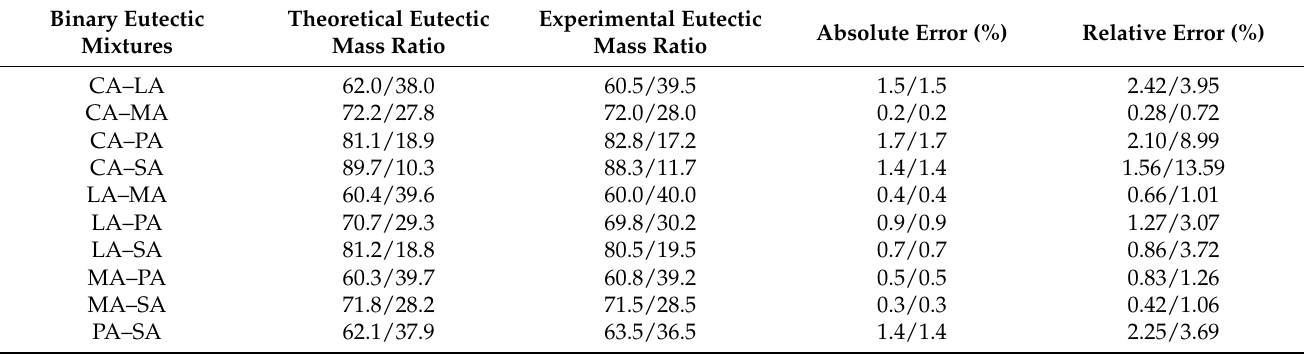
Table 3. Comparison of the eutectic mass ratios of ten binary eutectic mixes between theoretical and experimental values.